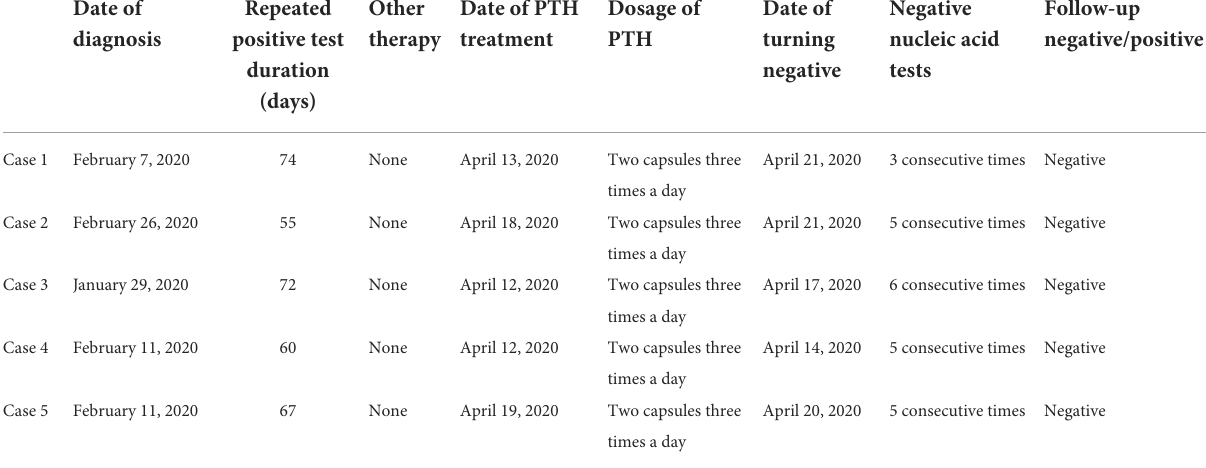
TABLE 3 PTH treatment for persistent positive SARS-CoV-2 test results in